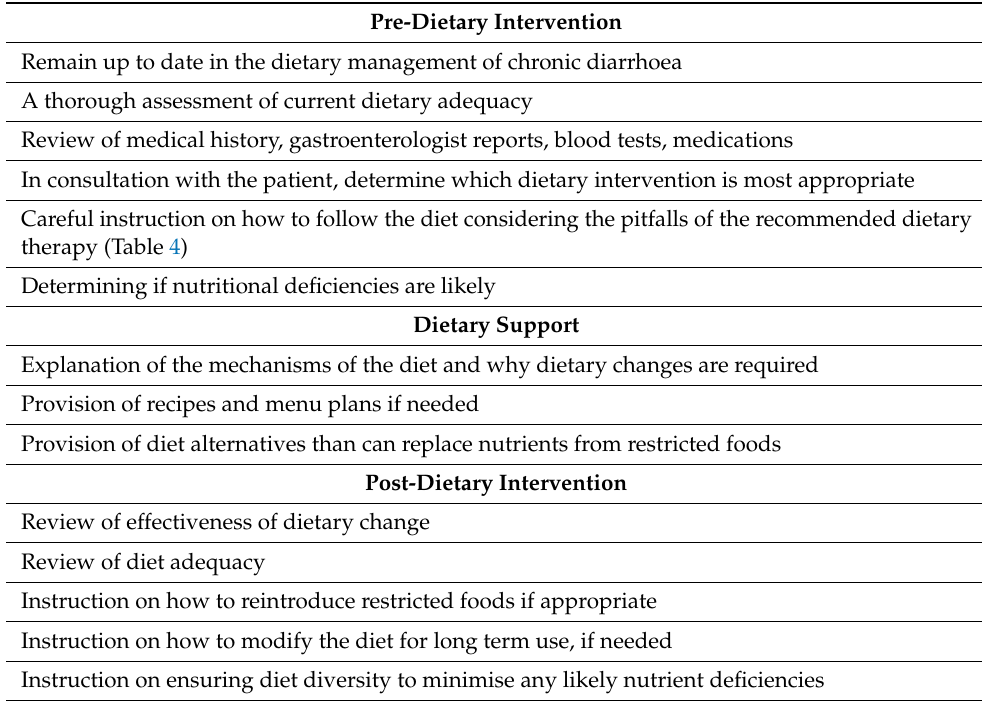
Table 5. The role of the dietitian in the management of diet-responsive chronic